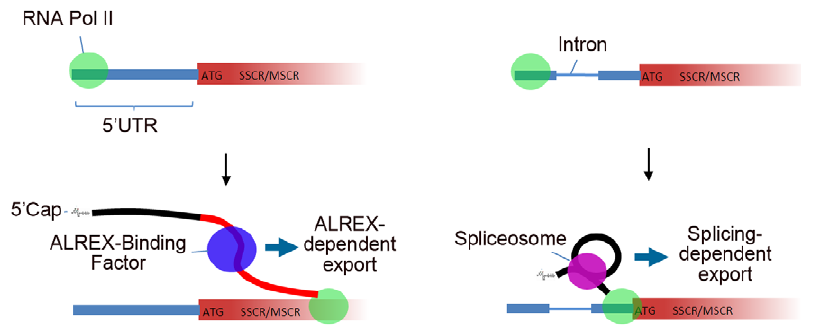
Figure 8. Model describing 5 9 UTR intron effects on nuclear mRNA export by genes with SSCR/MSCRs. (A) In the absence of 5UIs, the SSCR/MSCR is transcribed prior to any splicing event and as a consequence the transcript is exported via the ALREX pathway. (B) The presence of the 5UI results in recruitment of the splicesome and associated accessory proteins before the SSCR/MSCR is transcribed and hence the transcript is exported by the splicing-dependent pathway. As this transcript is not exported by the ALREX pathway, there is no selection pressure for the SSCR/ MSCR to maintain specific nucleotide features associated with ALREX.